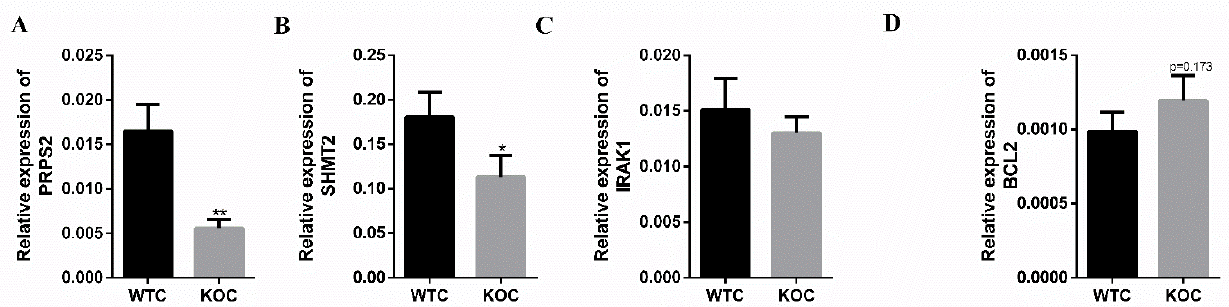
Figure 6. The expression of DMR-related genes. ( A – D ) Relative mRNA levels of Prps2 ( A ), Shmt2 ( B ), Irak1 ( C ), Bcl2 and ( D ) ( * p < 0.05, ** p < 0.01, n = 8).